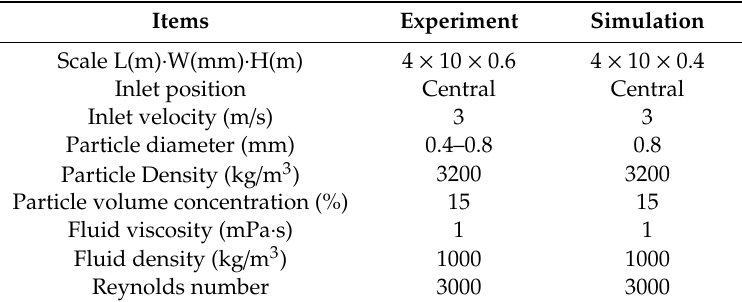
Figure 4. Proppant transport experimental system. Table 1. Parameters set for experiment and simulation. Table 1. Parameters set for experiment and simulation.